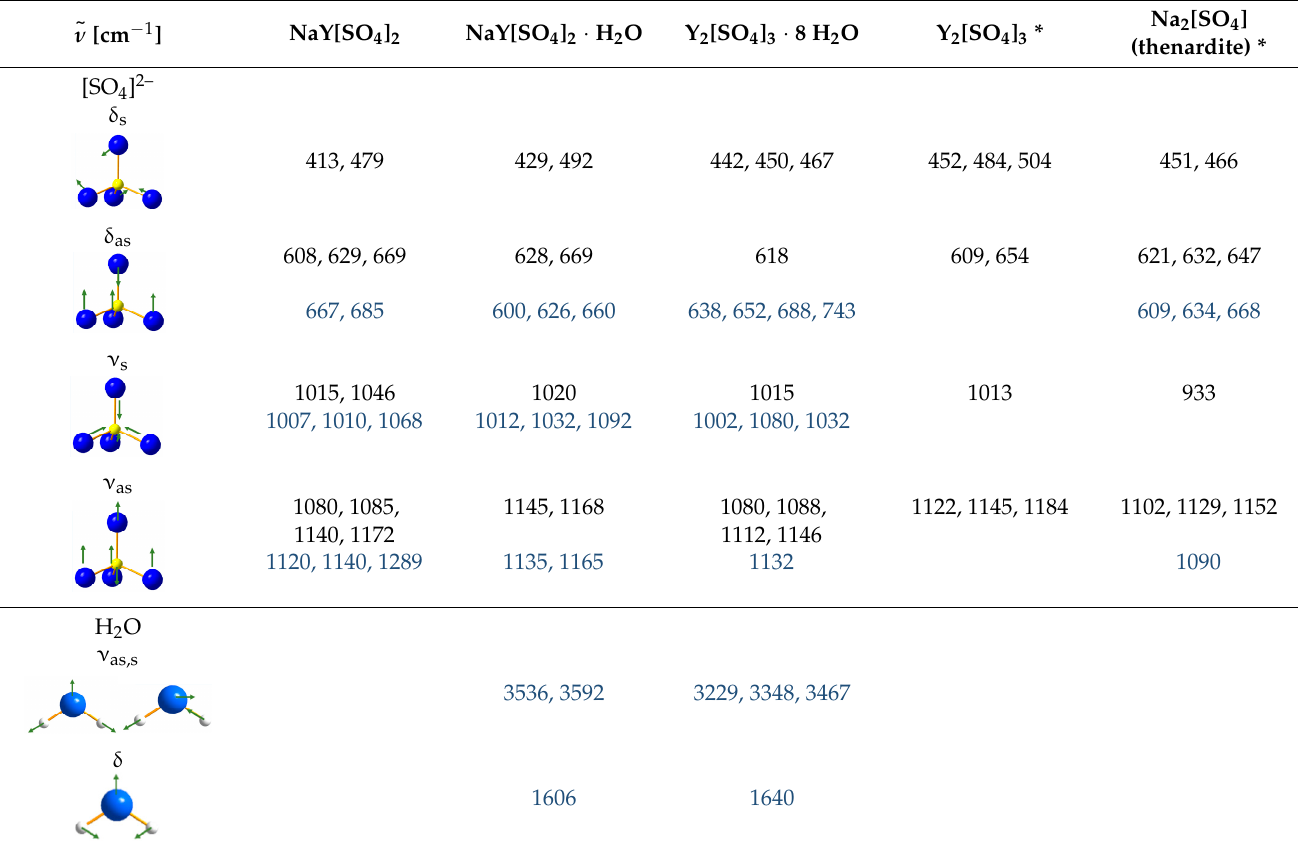
Table 6. Raman ( black ) and IR vibration values ( blue ) of NaY[SO 4 ] 2 and NaY[SO 4 ] 2 ∙ H 2 O as compared to those of Y 2 [SO 4 ] 3 ∙ 8 H 2 O, Y 2 [SO 4 ] 3 [69], and Na 2 [SO 4 ] (thenardite) [70].